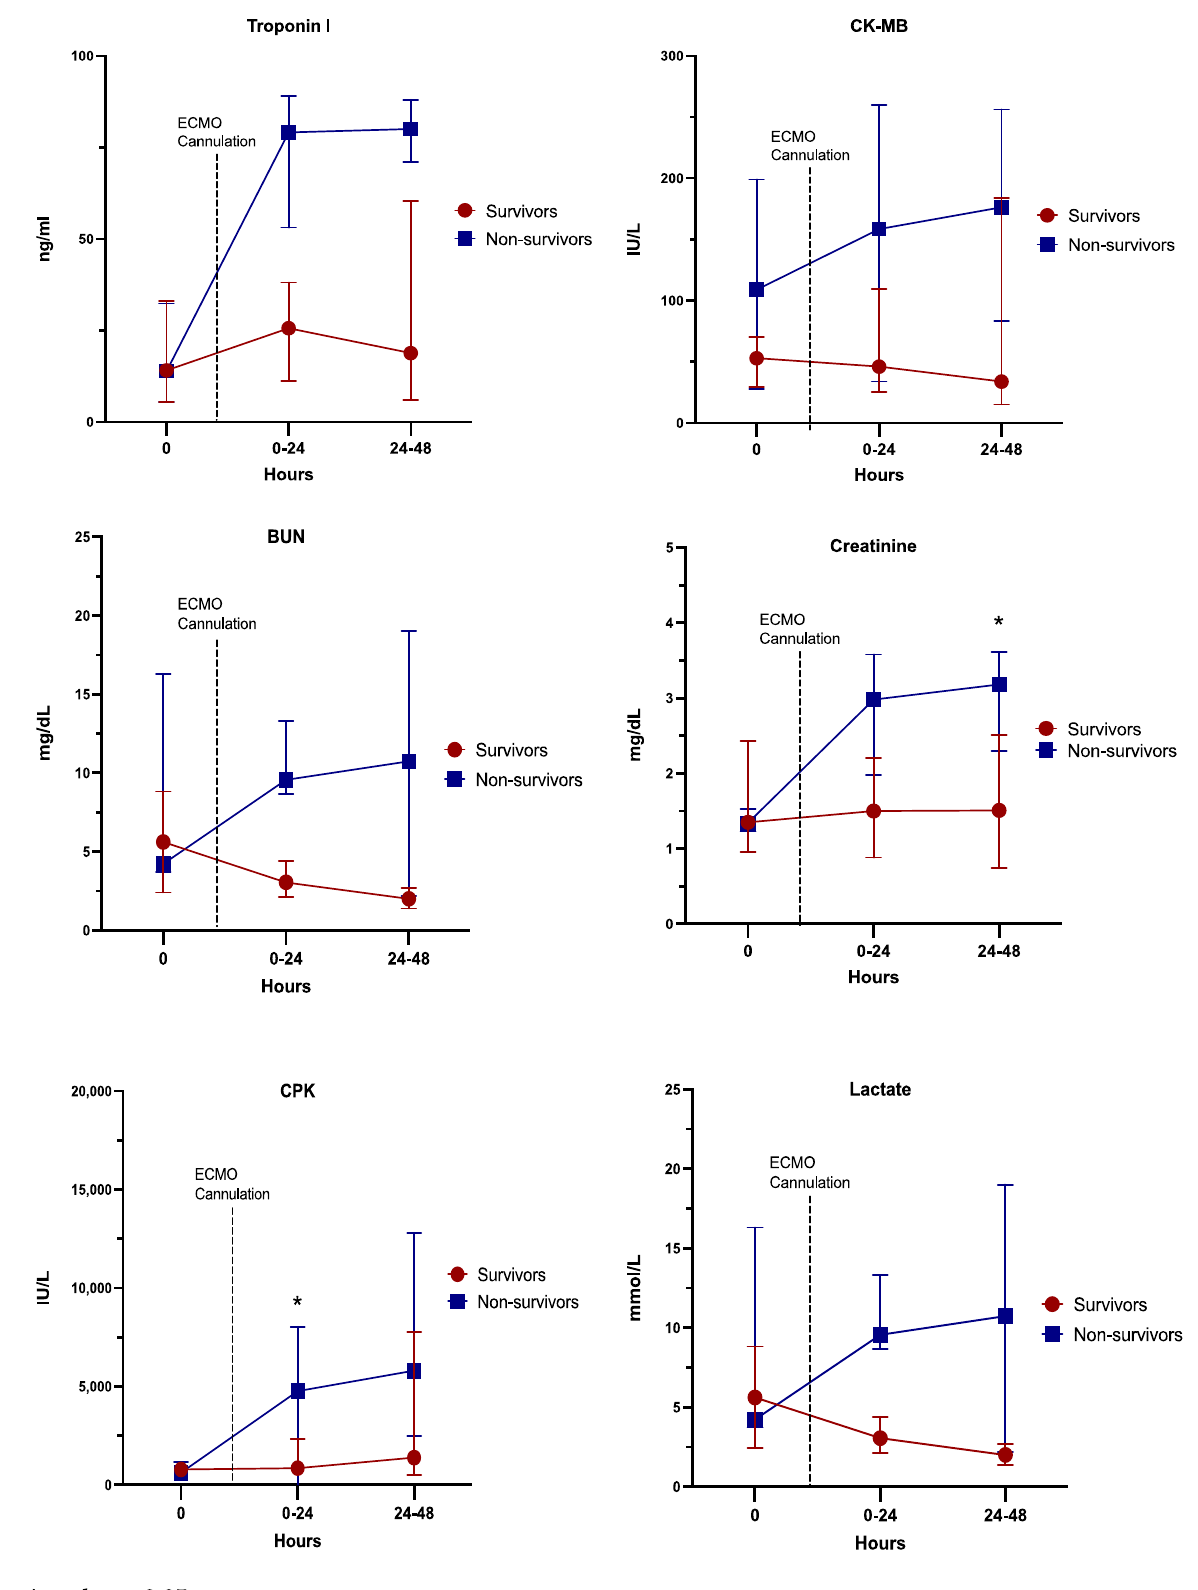
Figure 2. Laboratory data at different time points (24 h prior, 24 h after, and 24–48 h after ECMO support) among non-survivors and survivors. Table 3. Differences of variables within 24 h prior and after ECMO cannulation ( Δ ). Non-Survivors ( n = 6)